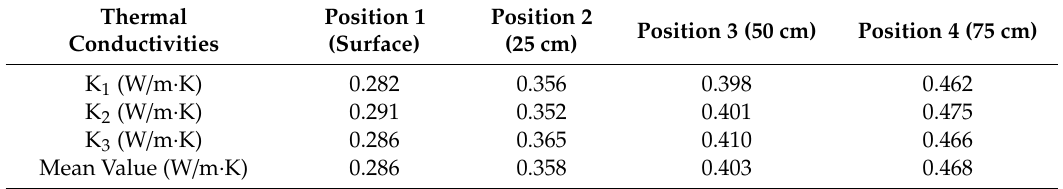
Table 10. Thermal conductivity results from the KD2 Pro measuring in each of the established depth